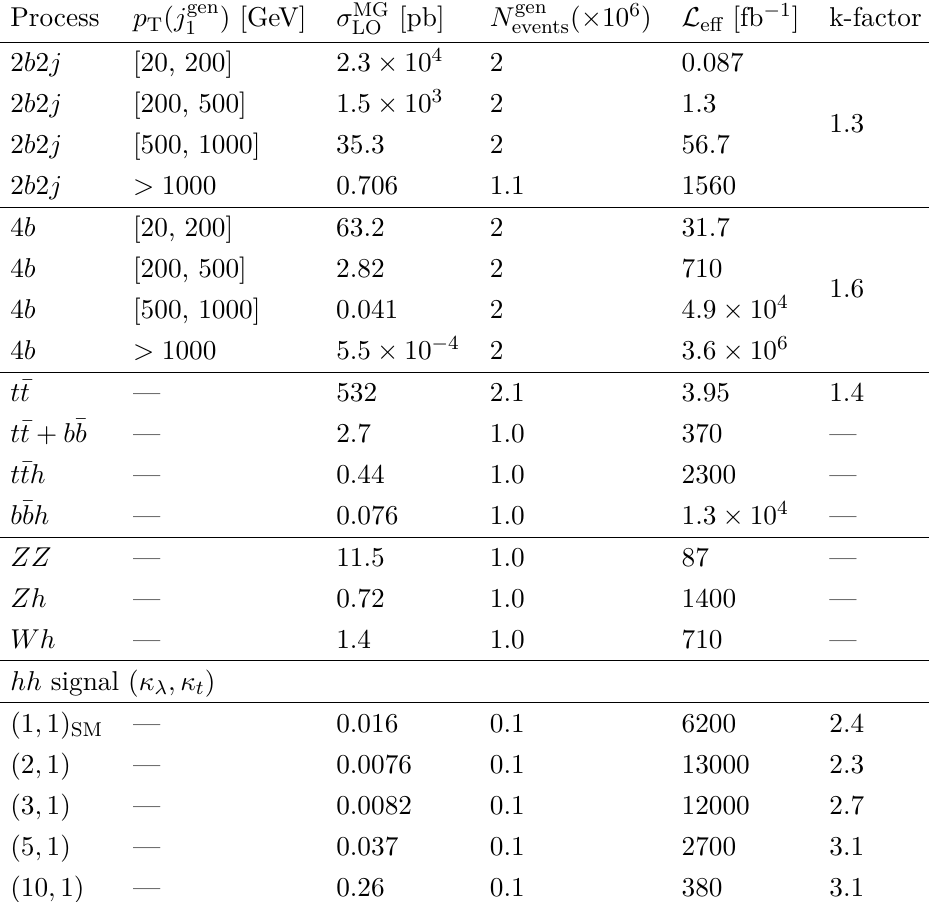
Table 1. Summary of Monte Carlo samples. The columns indicate any explicit parton level generator preselection on the leading parton p T ( j gen ) , the leading order MadGraph cross- 1 section σ MG , the number of events generated N gen , and an estimate of the effective luminosity events LO L eff = N gen /σ MG . The k-factor is a scaling factor applied to account for NLO corrections for the events LO dominant backgrounds, and overall higher order corrections for the signal described in the main text. Information for a representative set of signals are displayed in the bottom five rows. For the signals, higher statistics samples of 250k events per point are generated for neural network training as discussed in the main